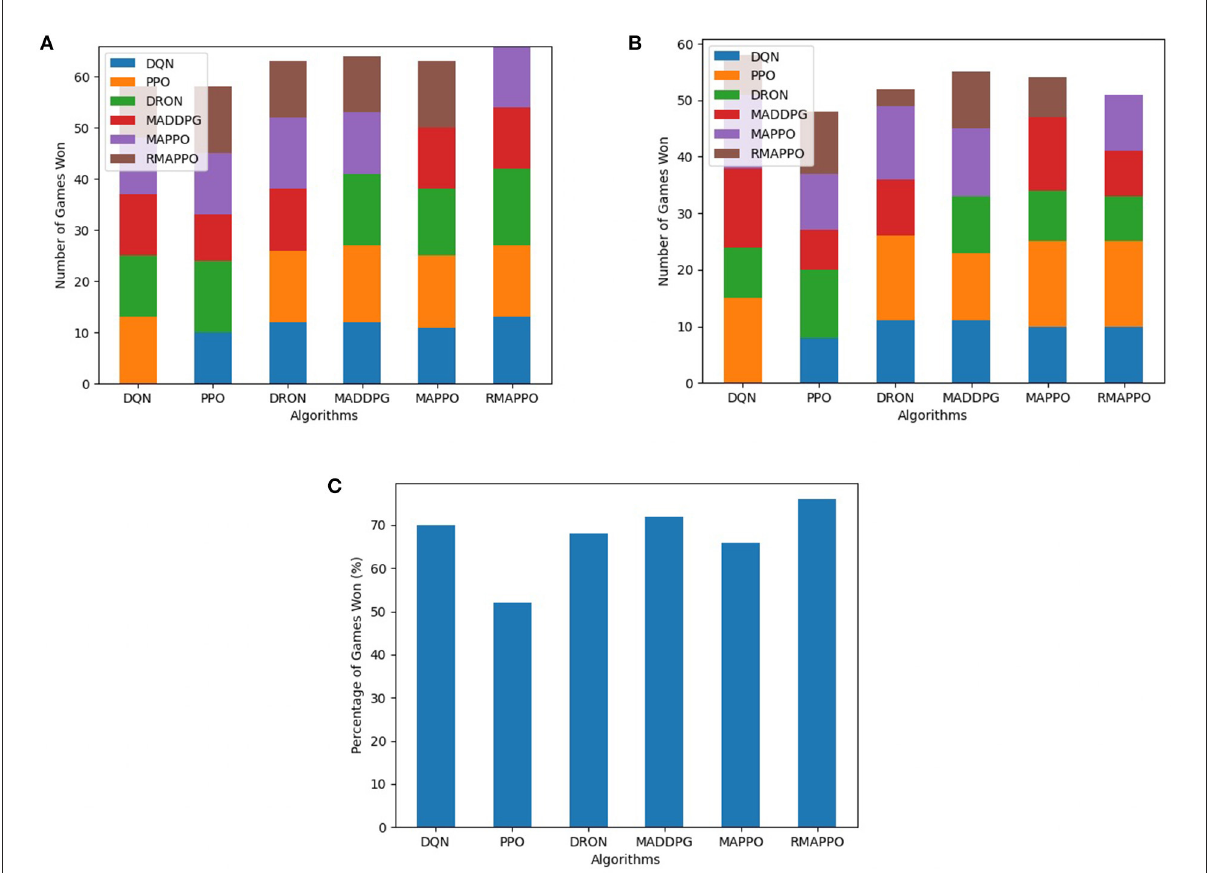
FIGURE5 Performance of various algorithms when playing against other algorithms in the Space War environment. (A) Shows the number of games won as the first player, (B) shows the number of games won as the second player, (C) shows the overall win rate percentage.